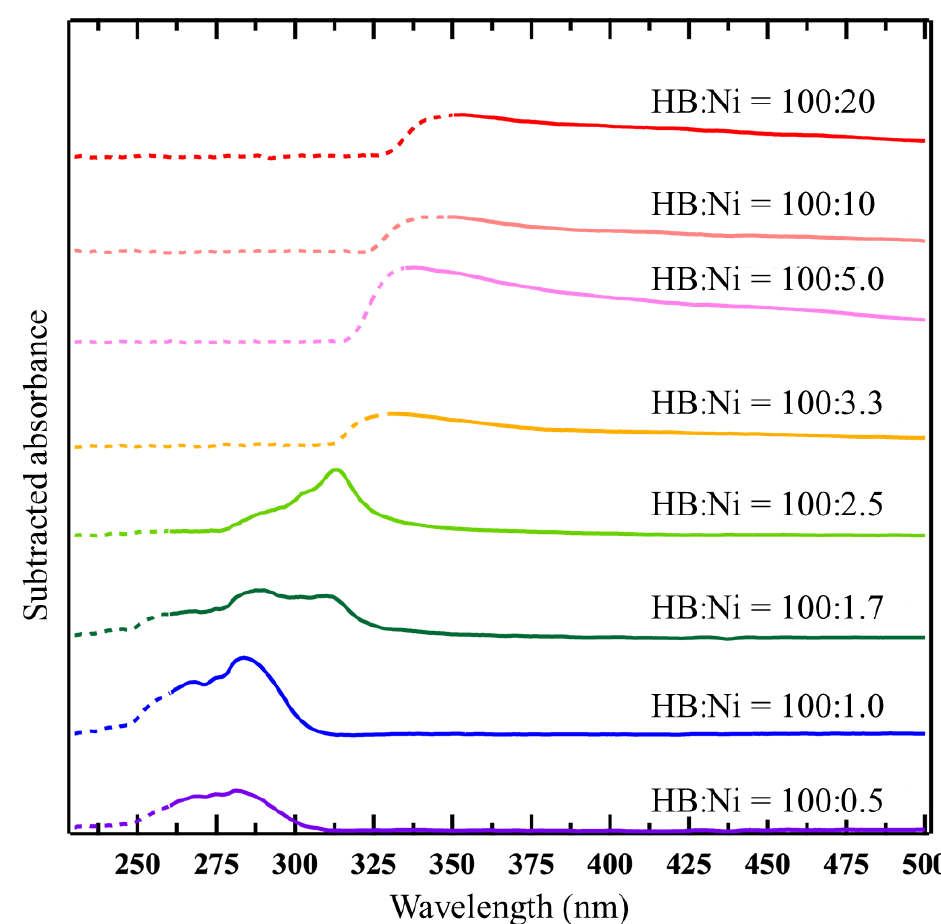
Figure 4. Respective subtracted spectra of HB:Ni = 100:20 (90 min), 100:10 (120 min), 100:5.0 (120 min), 100:3.3 (120 min), 100:2.5 (120 min), 100:1.7 (120 min), 100:1.0 (120 min), and 100:0.5 (120 min).